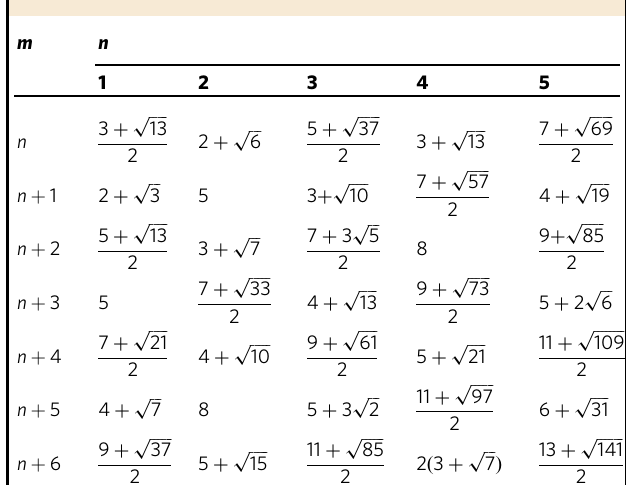
Table 1 In fl ation factors of type IA tilings with 1 ≤ n ≤ 5 and n ≤ m ≤ n + 6